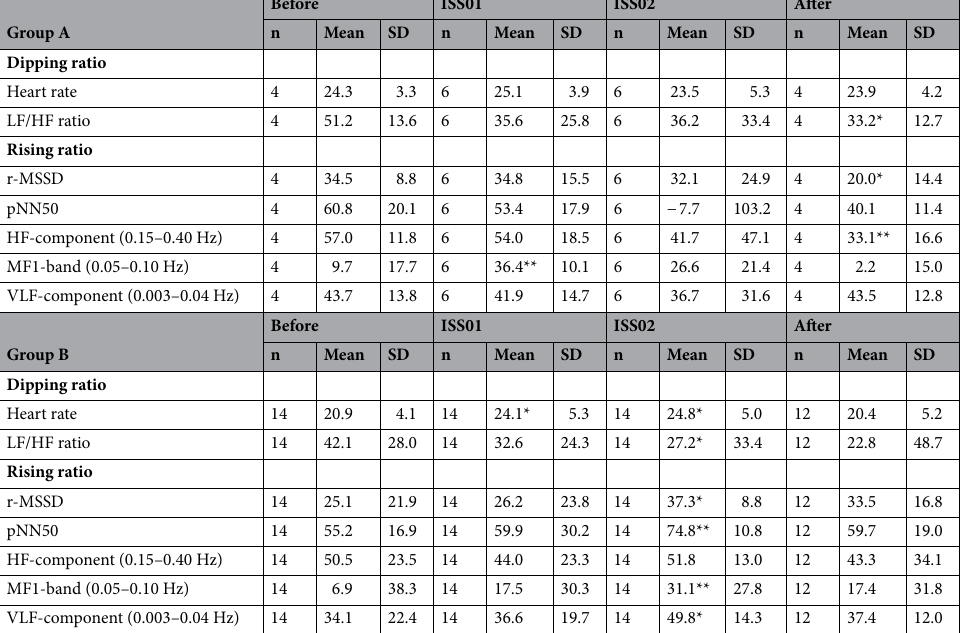
Table 4. Its circadian amplitude also correlated with the circadian amplitude of the VLF-component (r = 0.7383, P = 0.0148). An effect of magnetic fluctuations was not found to affect the circadian acrophase of HR or any of the HRV endpoints.